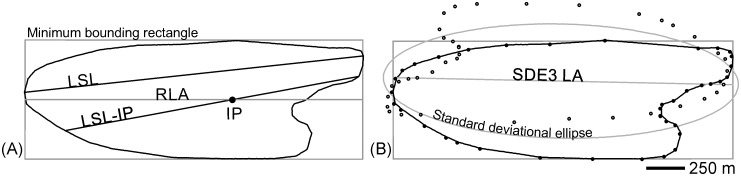
Derivation of automated longitudinal axes.A) LSL—longest straight line enclosed by the footprint; LSL-IP—longest straight line crossing the footprint’s innermost point (IP); RLA—rectangle longitudinal axis. B) Longitudinal axis of the standard deviational ellipse (SDE) [18] computed using the footprint’s structural vertices and their 180°-rotated version (one of three tested SDEs). In the illustrated case, the ellipse’s axis is longer than the drumlin and thus was cropped to the minimum bounding rectangle’s extent.